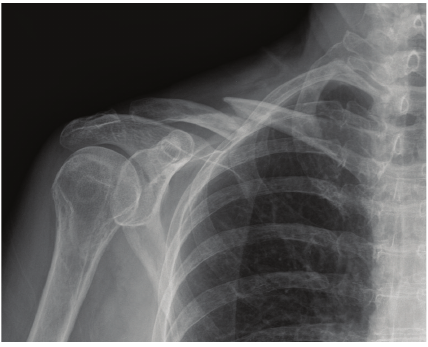
Figure 1: Radiograph from date of injury showing the right mid- shaft clavicle fracture. A 2.5cm fragment is displaced posteriorly, but is not seen well in this radiograph.